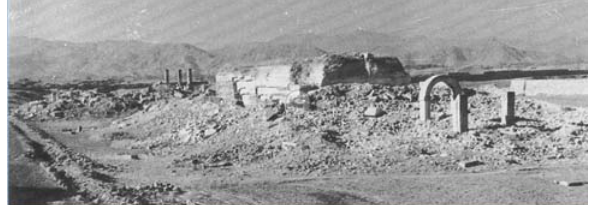
Figure4. Exposed site of rammed earth station after the block collapse at 1940s